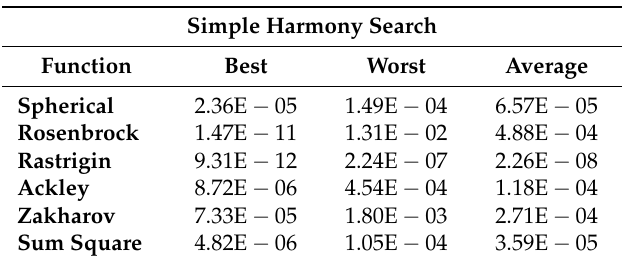
Table 2. Results obtained using the harmony search algorithm.